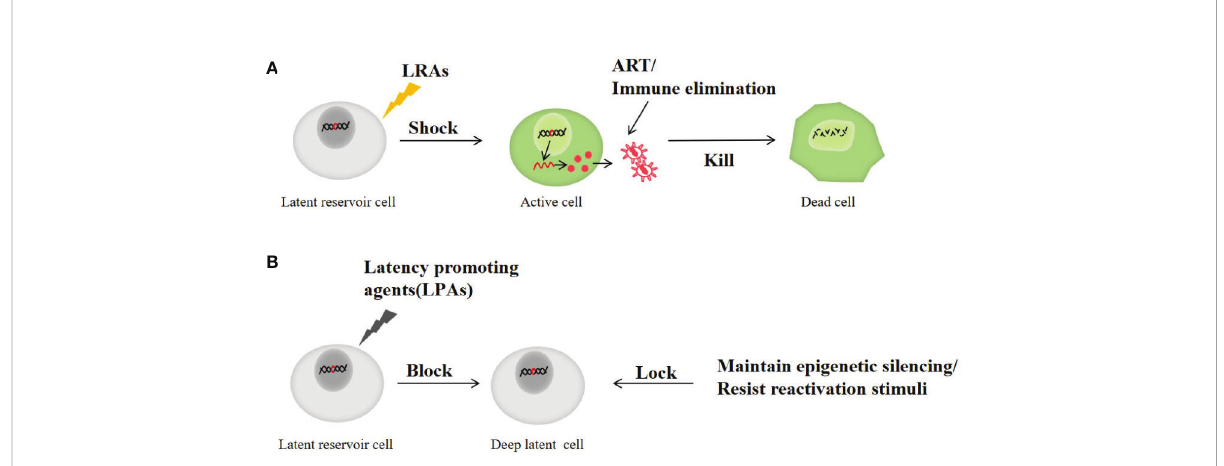
FIGURE 3 The main process of shock and kill and block and Lock therapy to clear latent reservoir of HIV. (A) Shock and kill strategy: the latent HIV is activated with a LRAs and then killed by ART or immunotherapy. (B) Block and lock strategy: by preventing the transcription and reactivation of HIV in latent infection cells to inhibit the emergence of latent virus and prevent virus